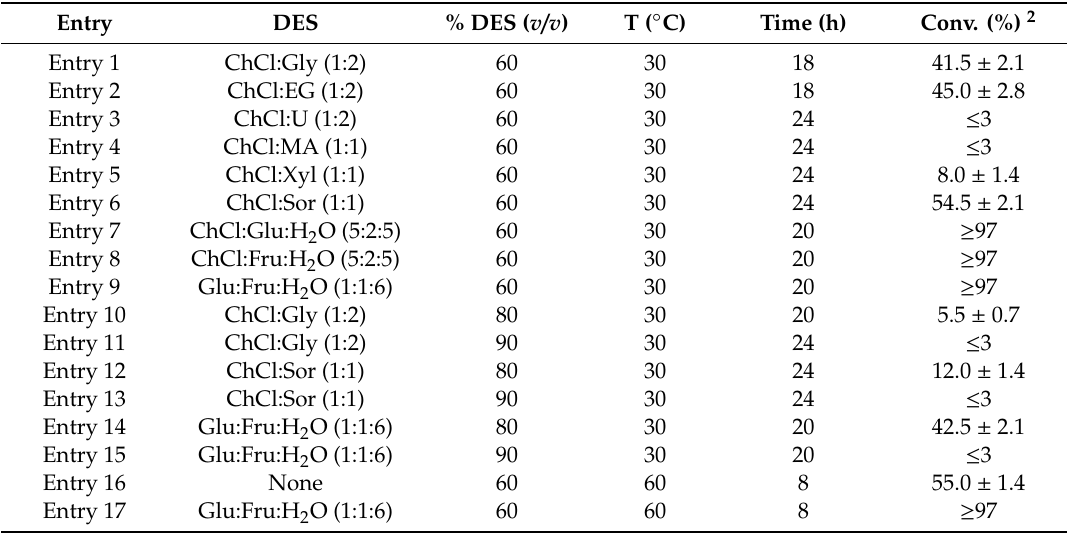
Table 2. HMFO-biocatalyzed oxidation of alcohol 5a in bu ff er / DES medium 1